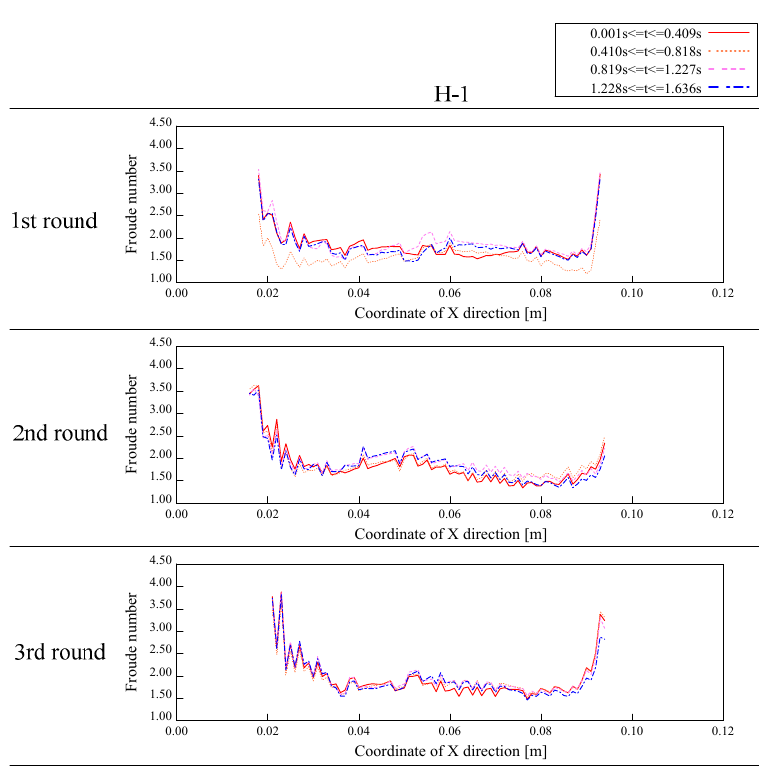
Figure 12. Relationship of the flow velocities in each cross section by combining the horizontal and vertical flow velocities for every 409 frames (0.409 s) of four 1636 frames from M-1.